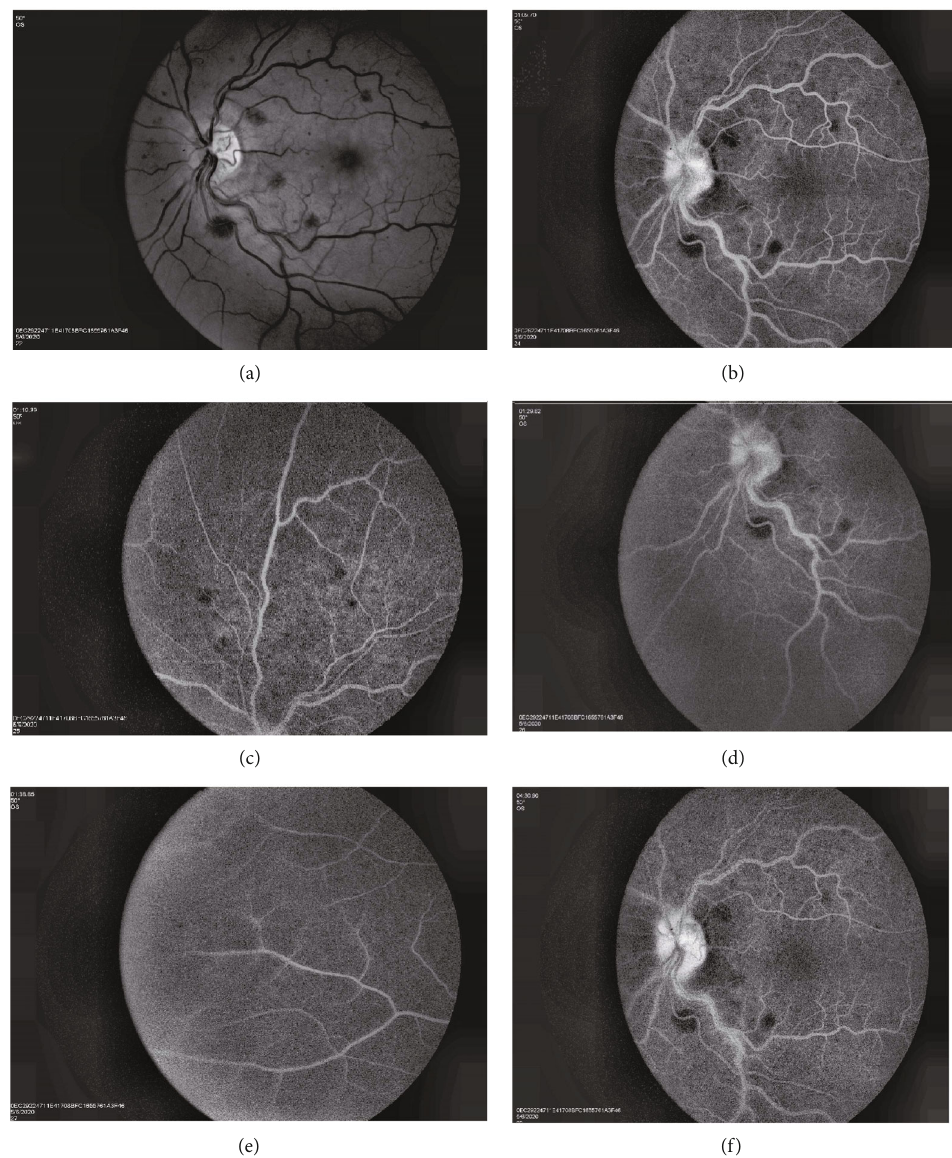
Figure 3: Fluorescein angiography (FA) images OS shows a masking e ff ect due to blot hemorrhages and early punctuate leakage in the upper retina: (b) 1.09min, (c) 1.19 min, (d) 1.29min, (e) 1.38min, and (f)